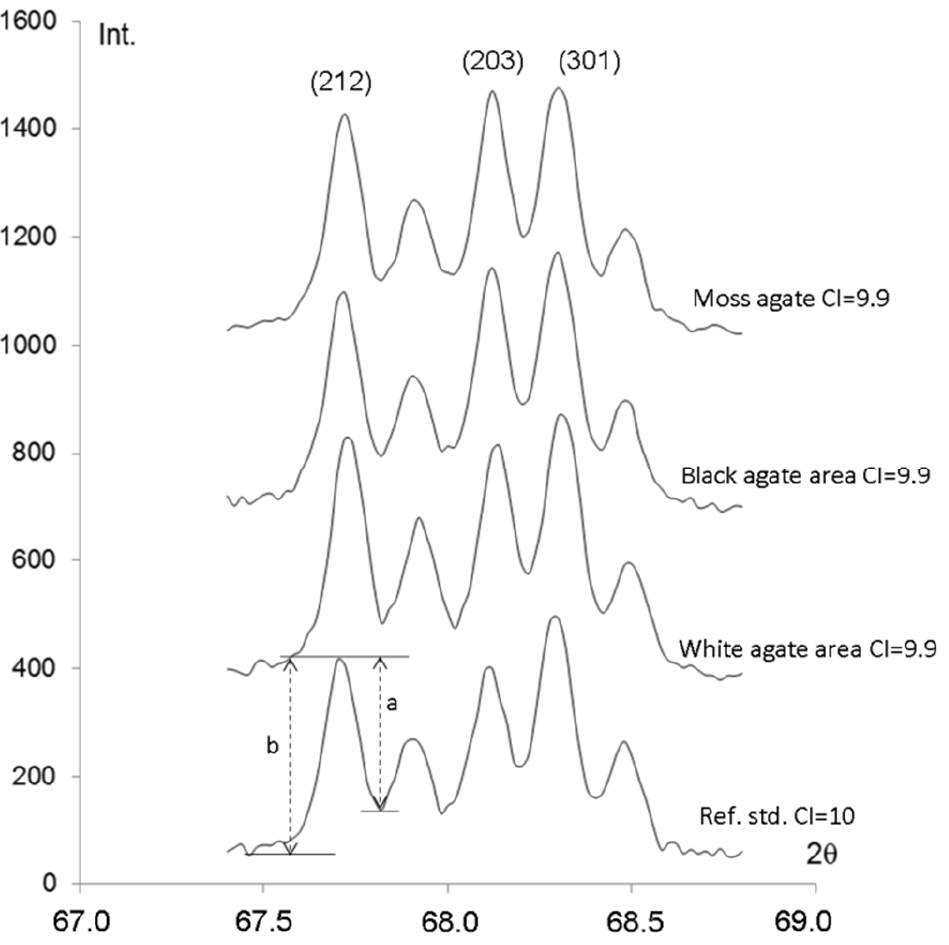
Figure 6. Fragments of X-ray diffractograms of the spherulitic agate, moss agate, black and white agate of concentrically zoning agate, and quartz crystal (Ref. std., Subpolar Urals), with the 2 θ 68 ° quintuplet peak. a and b parameters are measured for Crystallinity Index (CI) calculation.